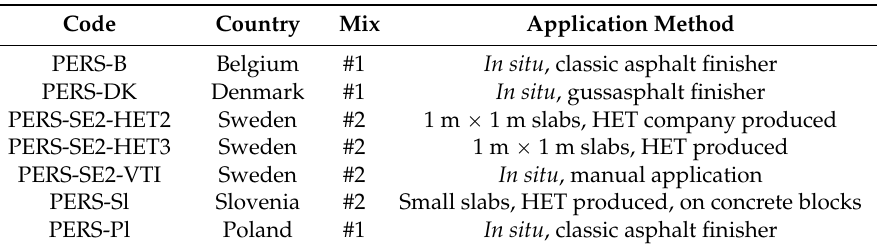
Table 1. Description of test